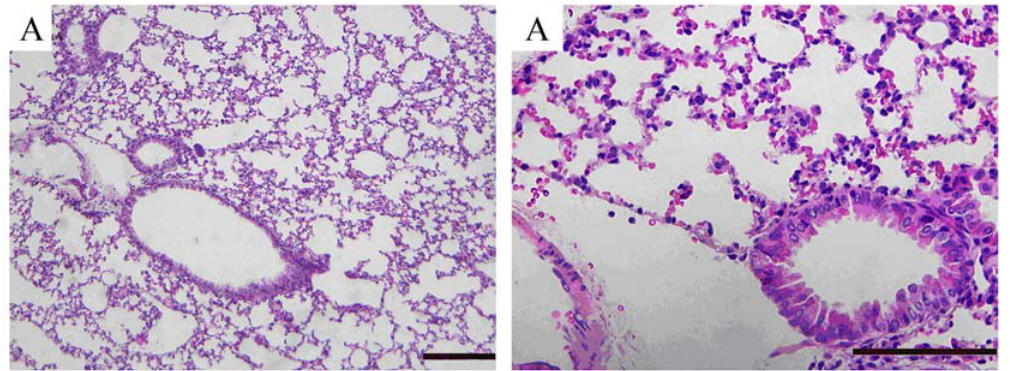
Figure 5. Effects of ginkgolide B on airway inflammation. Representative haematoxylin-eosin stained sections of lung from: ( A ) PBS-challenged mice; ( B ) OVA-challenged mice; ( C ) OVA-challenged mice treated with ginkgolide B. The left panel is magnified × 100, scale bars = 100 μ m. The right panel is magnified × 400, scale bars = 50 μ